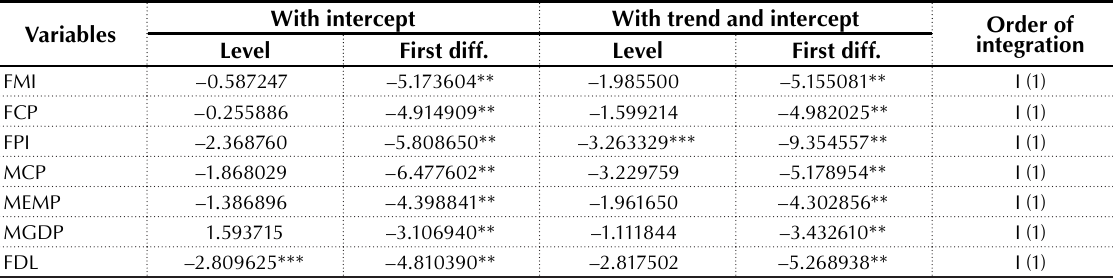
Table A1. Summary of the ADF unit root test of the series